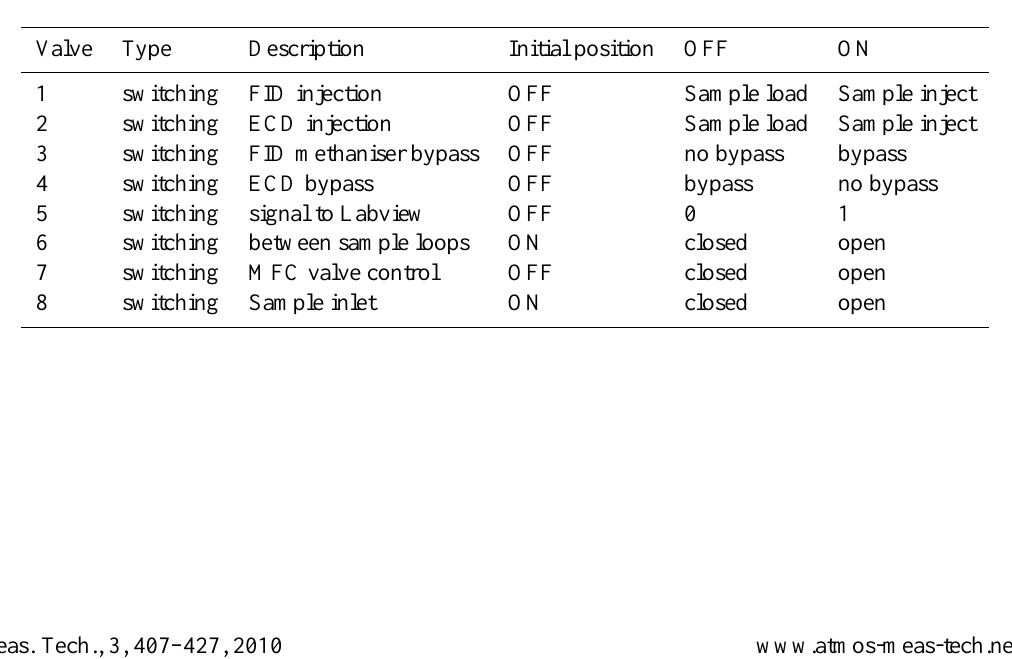
Table A1. Vavles